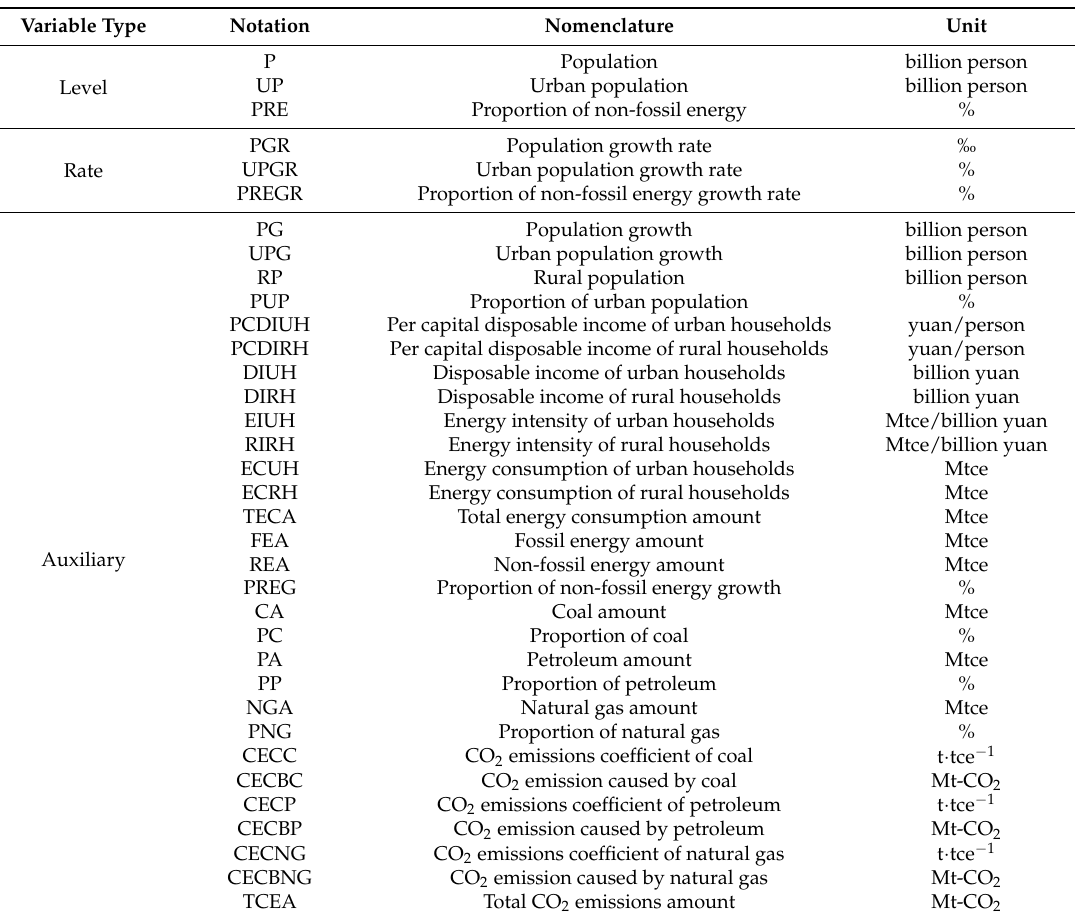
Table 2. Mathematical notations and